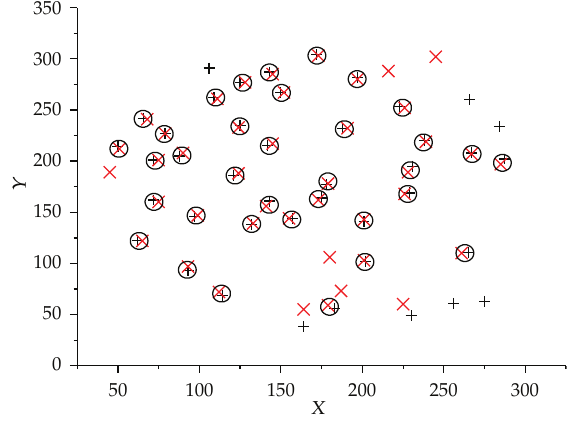
Figure 5: Matched pairs between Figures 4 (cid:6) a (cid:7) and 4 (cid:6) b (cid:7)